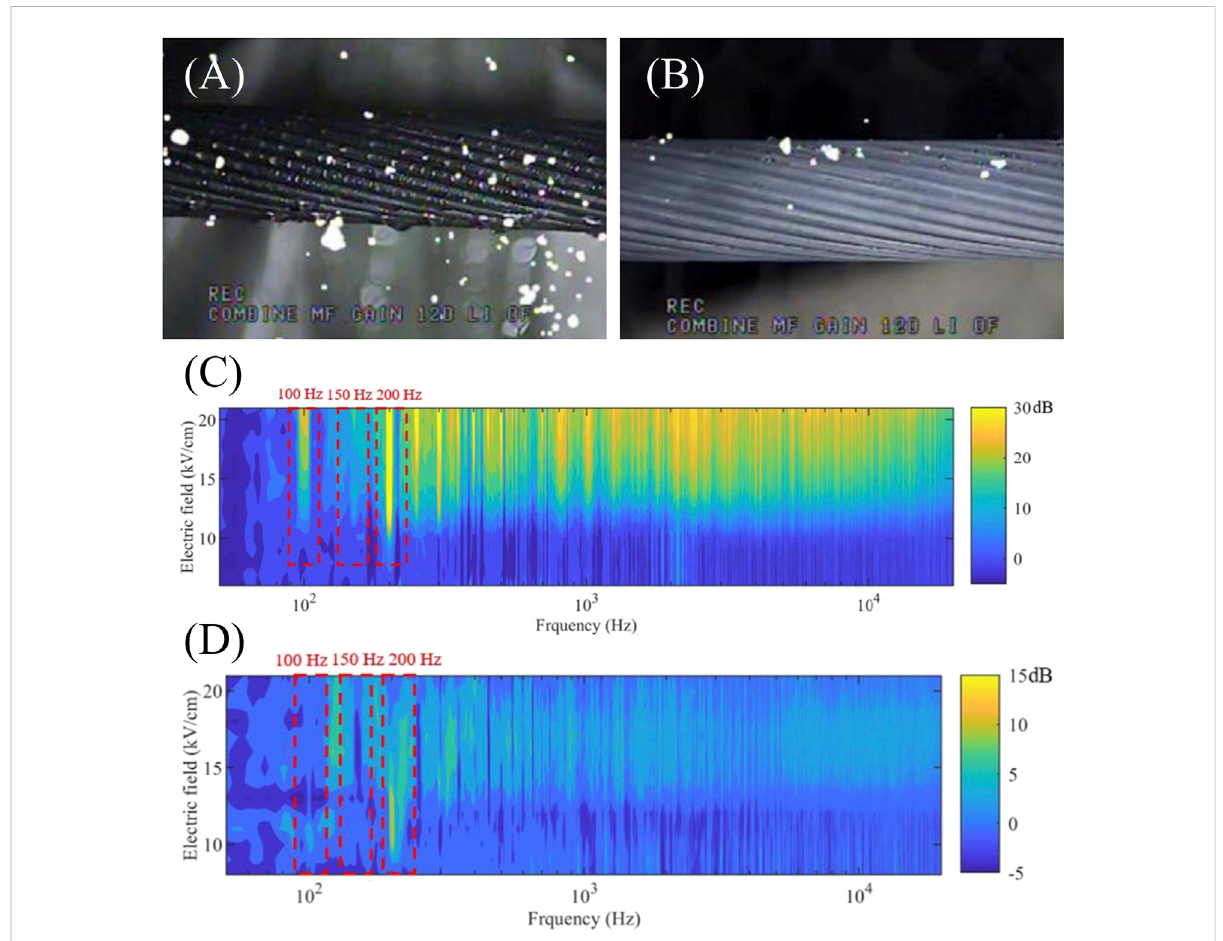
FIGURE 4 The images captured by the UV camera of (A) uncoated conductors, (B) coated conductors (Zhang et al., 2022). Measured noise levels (dB above background) as a function of electric fi eld and frequency with continuous water spray on (C) uncoated conductors, (D) coated conductors (Zhang et al.,